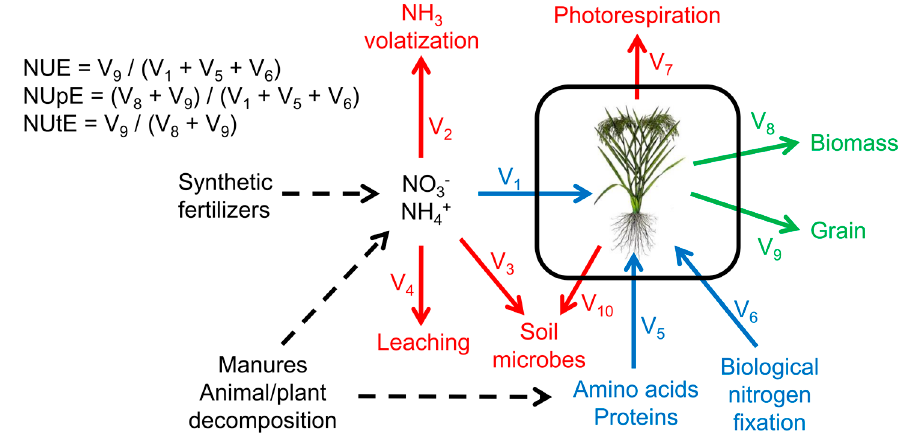
Figure 4. A simplified model of boundary fluxes in nitrogen use of crop plants. NUE: Nitrogen use efficiency, NUpE: Nitrogen uptake efficiency, NUtE: Nitrogen utilization efficiency.